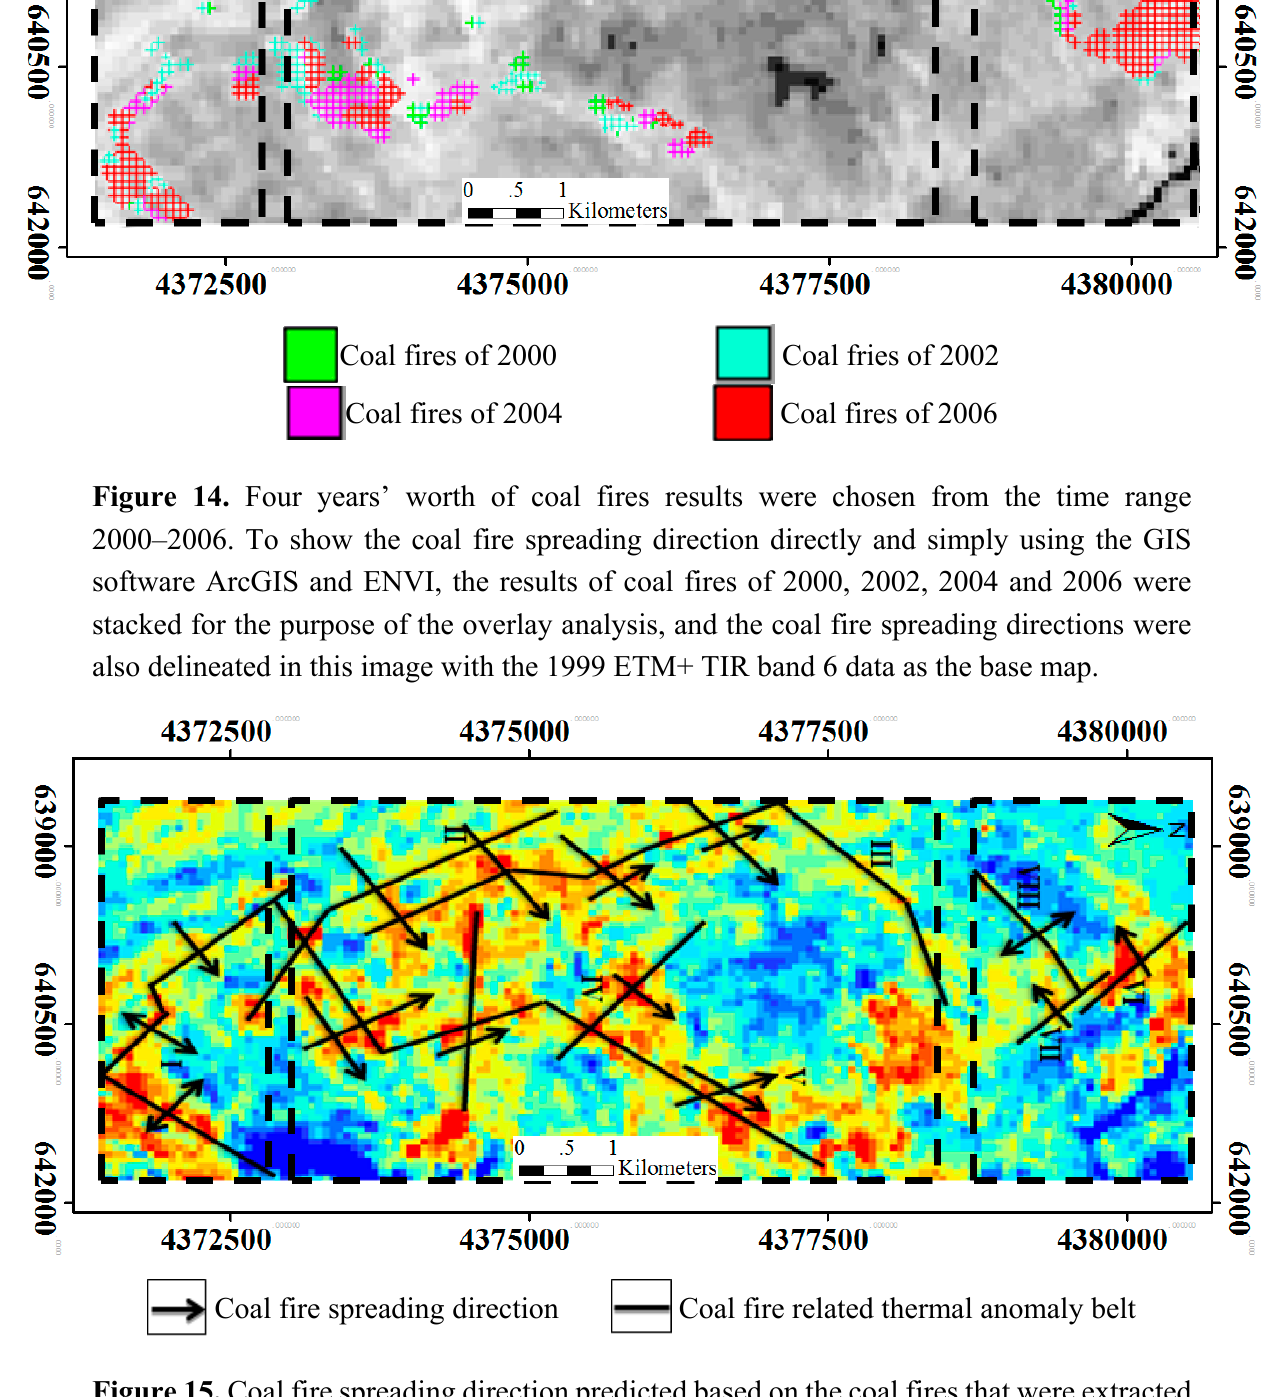
Figure 15. Coal fire spreading direction predicted based on the coal fires that were extracted from long-time series satellite data (See Figure 11) and the base map was 1999 Landsat ETM+ thermal band 6 data, which was sliced with the color table using the ENVI software. The lines of the coal fire spreading direction were drawn using ArcGIS